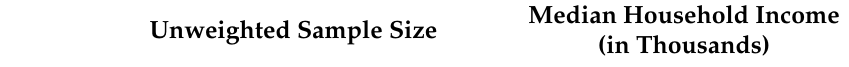
Descriptive statistics for sample sizes and median household income across the 51